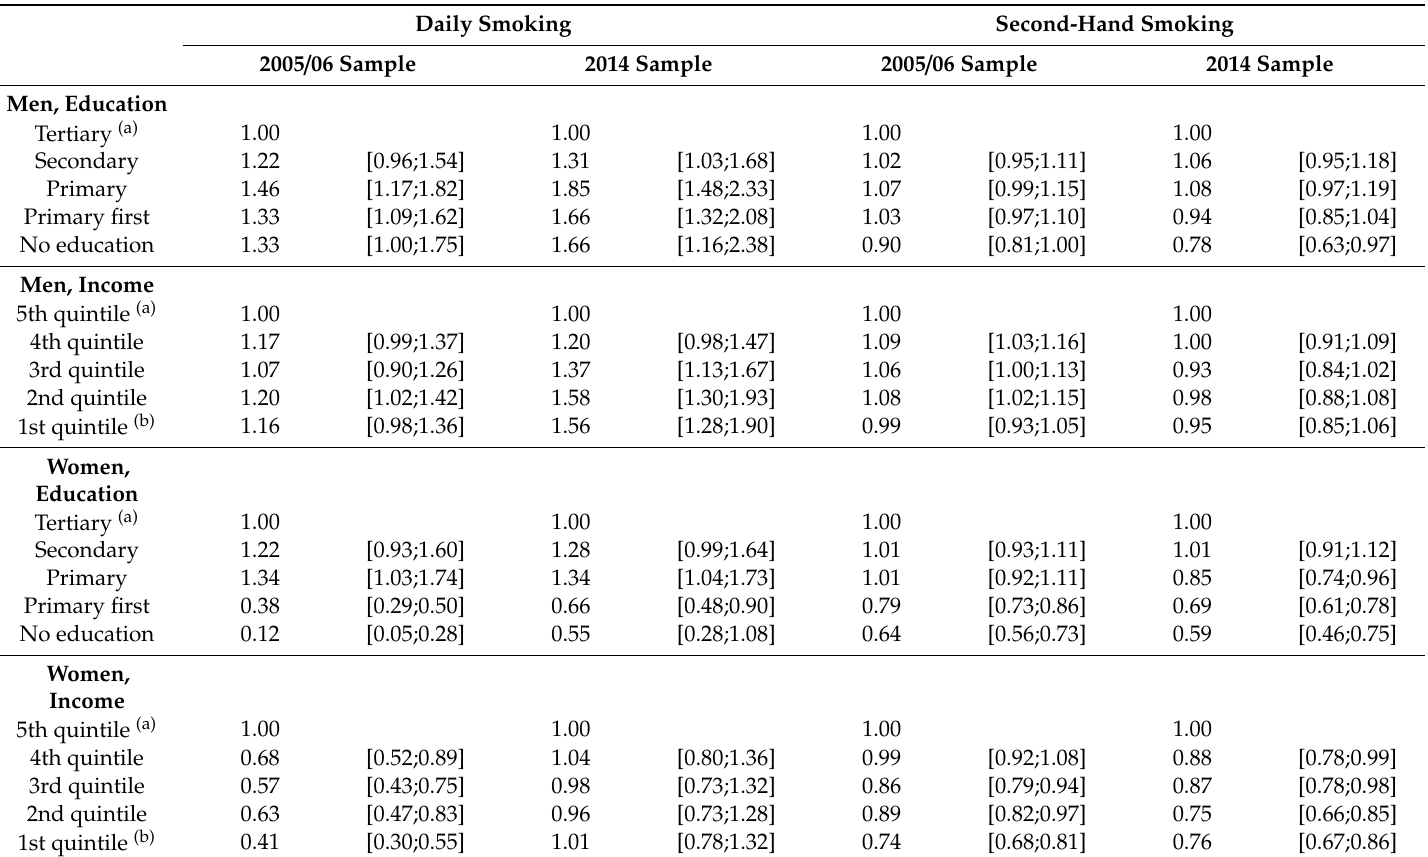
Table 3. Age-adjusted prevalence ratio of daily smoking and SHS exposure, stratified by sex, socioeconomic variable and